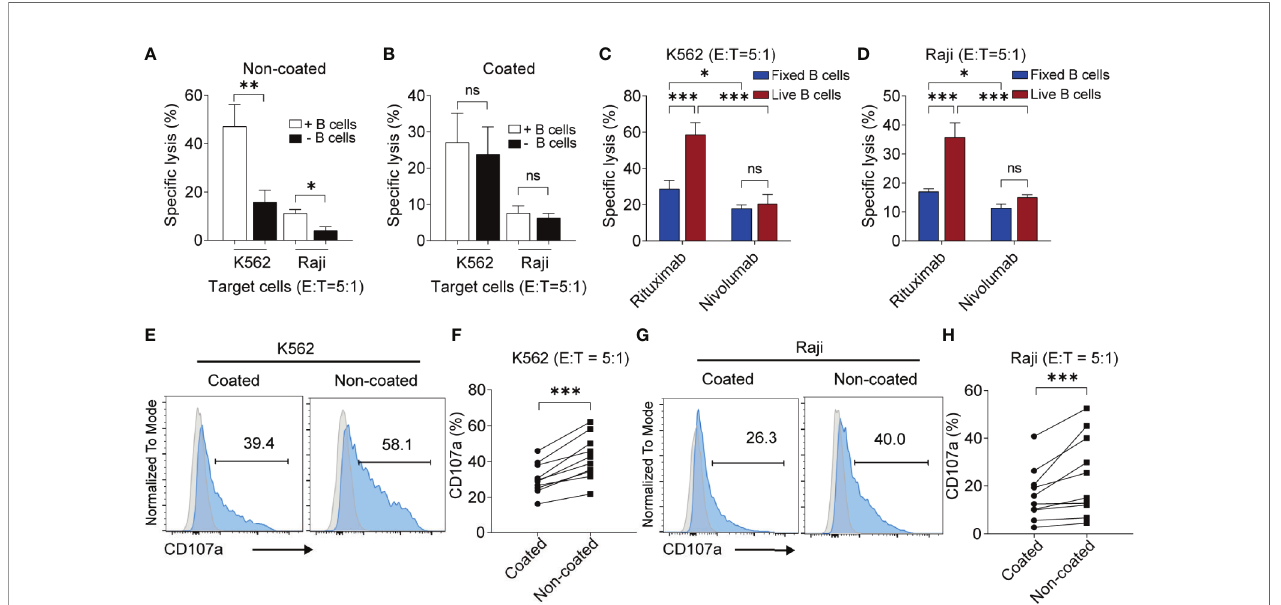
FIGURE 2 | Non-coated rituximab induced highly cytotoxic NK cells from peripheral blood mononuclear cells via autologous living B cells. (A, B) Cytotoxicity of NK cells induced from PBMCs with and without B cells. PBMCs (with and without B cells) were used to expand NK cells with coated or non-coated rituximab. After 14 d in culture, cells were harvested and cytotoxicity was determined by calcein-release assay. n = 5 donors, ns, not signi fi cant, p > 0.05, * p < 0.05, ** p < 0.01; two-tailed paired t-test. (C, D) Cytotoxicity of NK cells induced by living and fi xed (dead) B cells. B cells and NK cells were sorted from PBMCs, then living and fi xed B cells were incubated with NK cells according to the ratio of B cells and NK cells in PBMCs with rituximab or nivolumab. After 14 d in culture, cells were harvested and cytotoxicity was determined by calcein-release assay. n = 3 donors, ns: not signi fi cant, *** p < 0.001; two-way ANOVA. (E, G) Representative fl ow cytometry analysis of the percentage of CD107a + NK cells incubated with two different cancer cell lines. NK cells cultured with coated or non-coated rituximab were incubated with K562 or Raji cells for 4 h, followed by quanti fi cation of CD107a + cells. (F, H) Statistical analyses of CD107a + NK cells. NK cells induced with coated or non- coated rituximab were incubated with K562 or Raji cells for 4 h, followed by quanti fi cation of CD107a + cells. n = 10 donors, *** p < 0.001; two-tailed paired